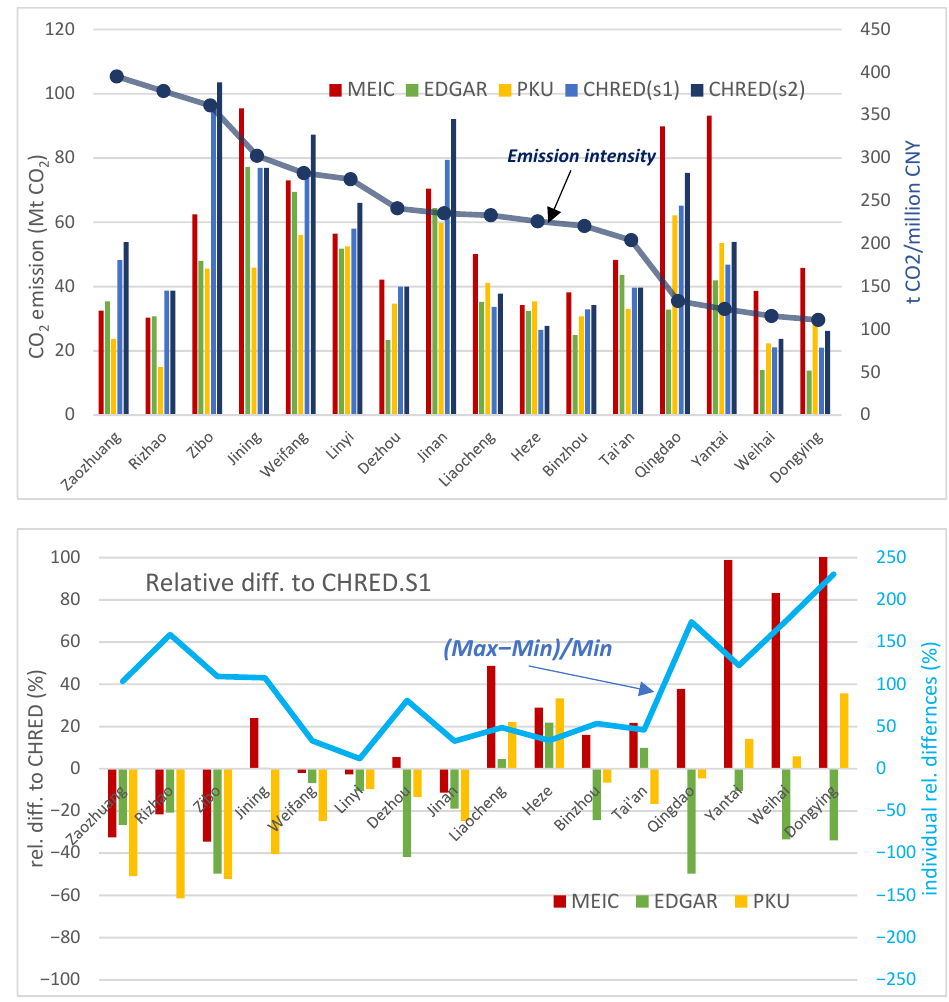
Figure 4. Top: CO 2 emissions of 16 cities in Shandong province from MEIC, EDGAR, PKU-CO2, and CHRED for 2010; bottom: the relative differences in MEIC, EDGAR, and PKU-CO2 in relation to CHRED s1. The cities are ranked according to their emission intensity (emission/GDP, shown as a dark blue line in the top panel). The light blue line in the bottom panel shows the differences (estimated by (max-min)/min) among the inventories.